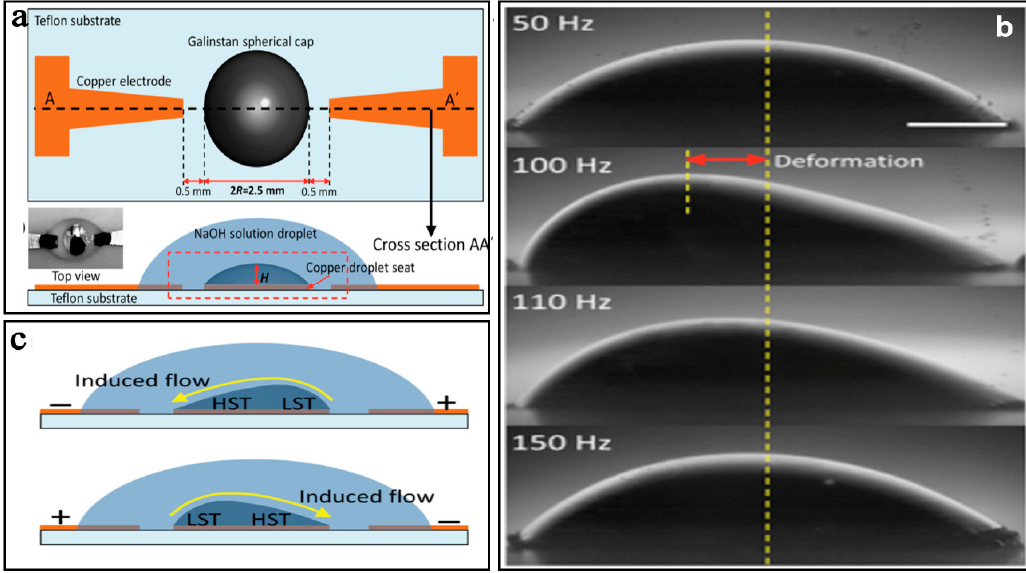
Figure 4. ( a ) Schematic of the micromixer with Galinstan cap; ( b )The deformation of the Galinstan cap by applying sinusoidal signals with different frequencies and magnitudes; ( c ) Flow velocity vectors (m/s) along the Galinstan surface. Reproduced with permission from [73].